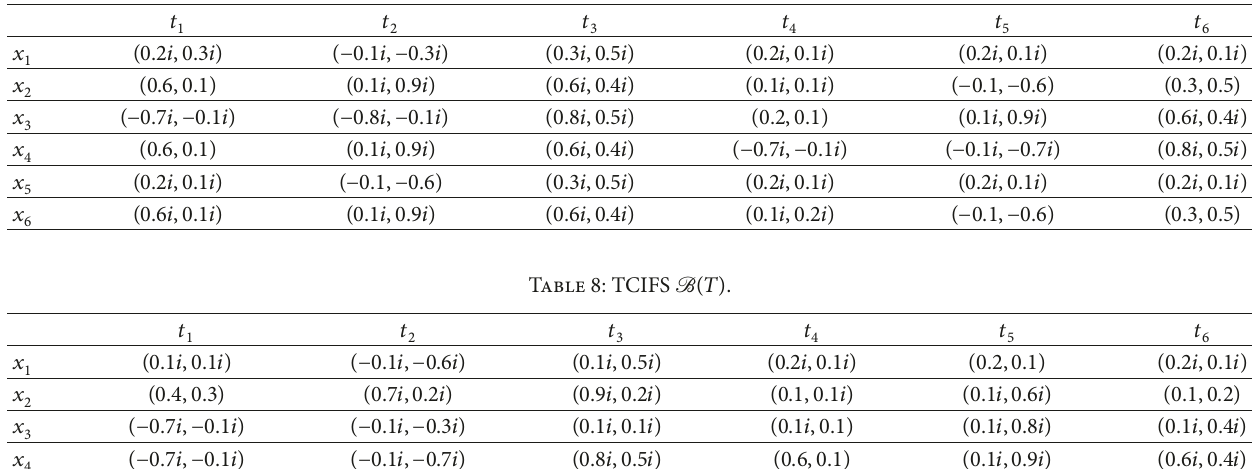
Table 7: TCIFS A (𝑇) .